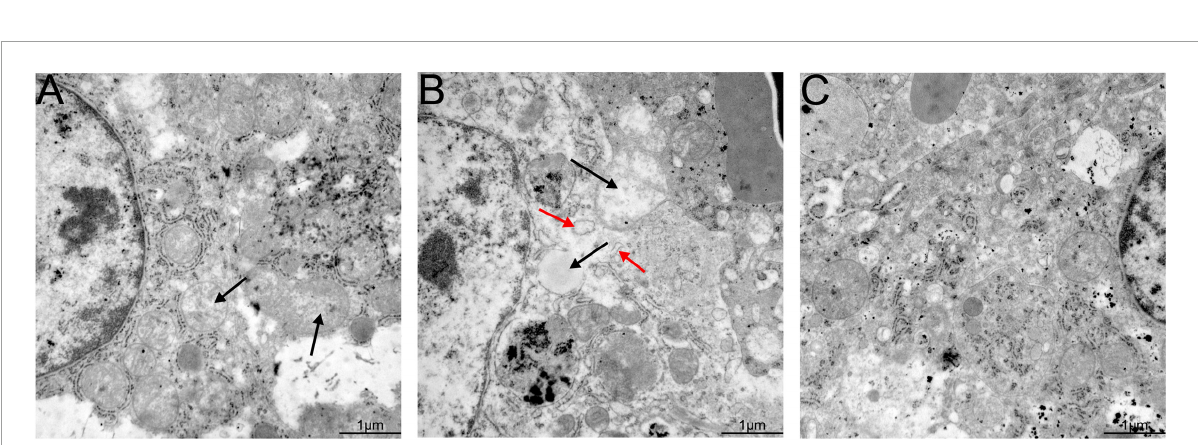
FIGURE7 Transmission electron microscopy (TEM) of liver tissues from necropsied rabbits. (A) Slight ultrastructural pathological changes, such as the loss of mitochondrial cristae, in the rabbits of the nb53 group. (B) Serious mitochondrial cristae loss and swollen mitochondria in hepatocytes in rabbits of the virus only or nb anti-PCV2 groups. (C) No visible ultrastructural changes in the rabbits of the nb14 and 1B5